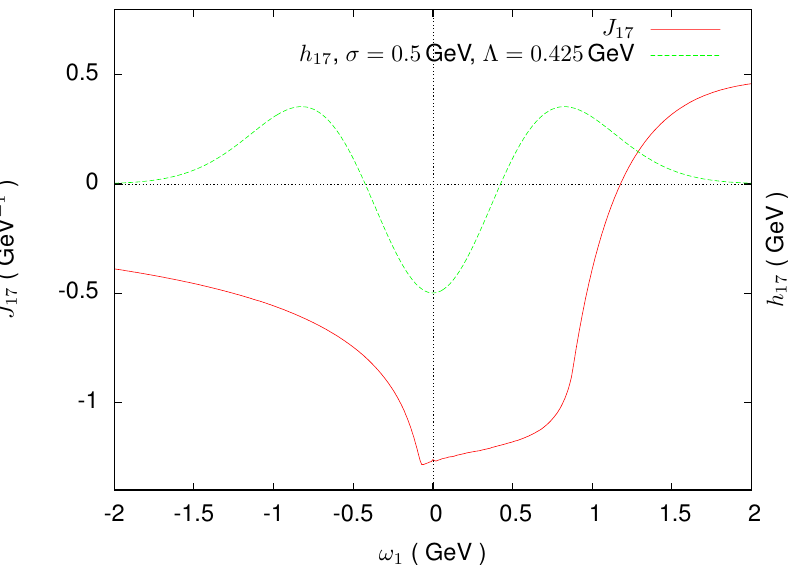
= 6 GeV 2 , together with the model function of equa- max